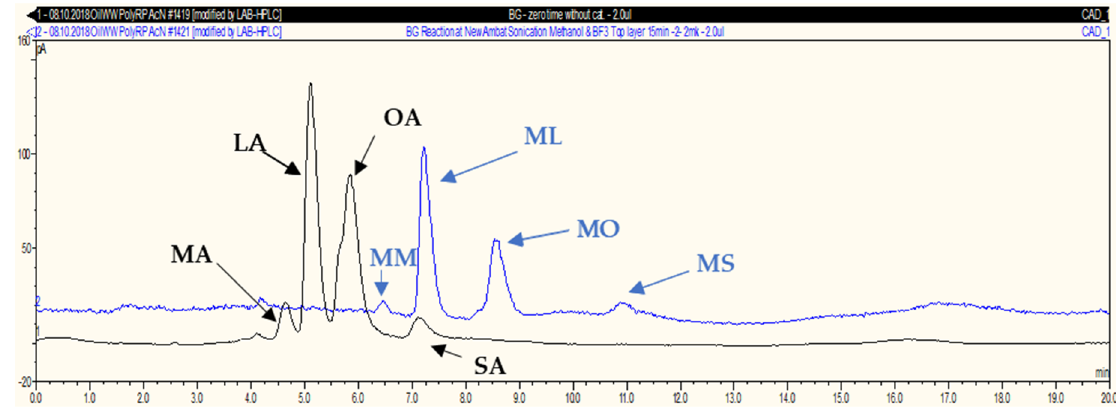
Figure 3. HPLC chromatographic profile of brown grease before and after esterification with methanol underbathultrasonicactivationfor15minattheambienttemperatureinthepresenceof5.33%(w / w)BF 3 . 5.33% (w/w) BF 3 . Black curve—chromatogram before the reaction; blue curve—after the reaction. Black curve—chromatogram before the reaction; blue curve—after the